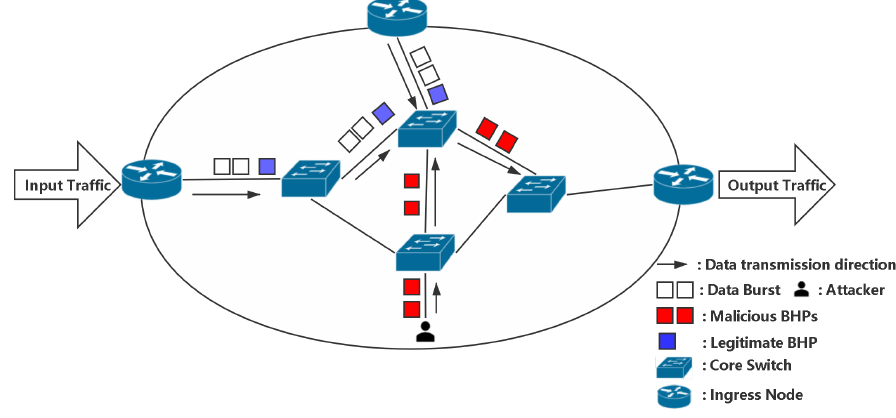
Figure 1. BHP flooding attacks in an OBS